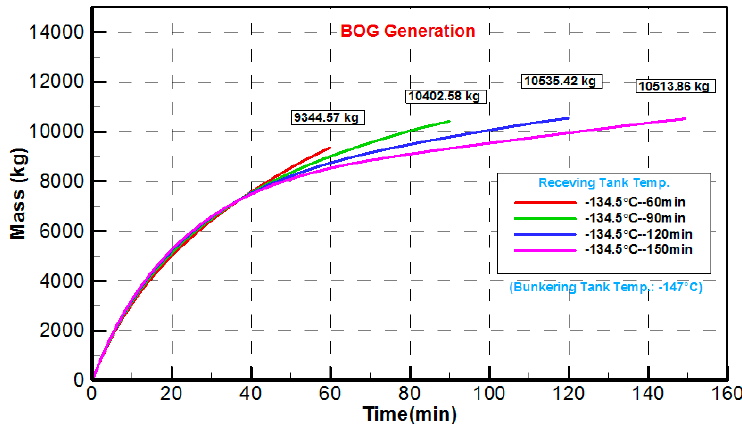
Figure 5. Effect of bunkering time on BOG generation at the receiving LNG storage tank.